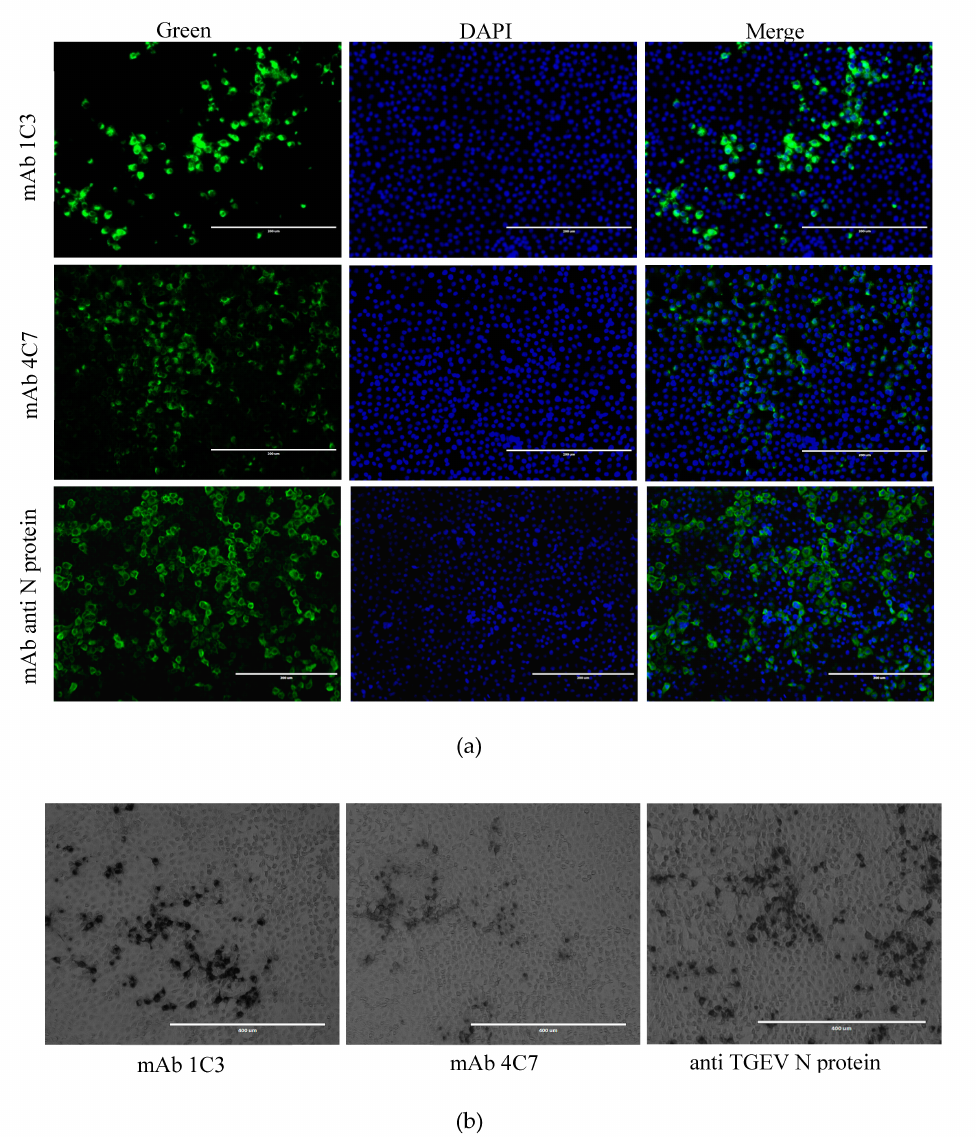
Figure 4. Application of the generated mAbs 1C3 and 4C7 in immunofluorescence assay (IFA) and immunoperoxidase monolayer assay (IPMA). ( a ) IFA analysis of the M protein in TGEV-infected PK-15 cells using 1C3 and 4C7 mAbs; ( b ) IPMA assay of the M protein in TGEV-infected PK-15 cells using 1C3 and 4C7 mAbs. The mAb against the N protein of TGEV was used as a positive